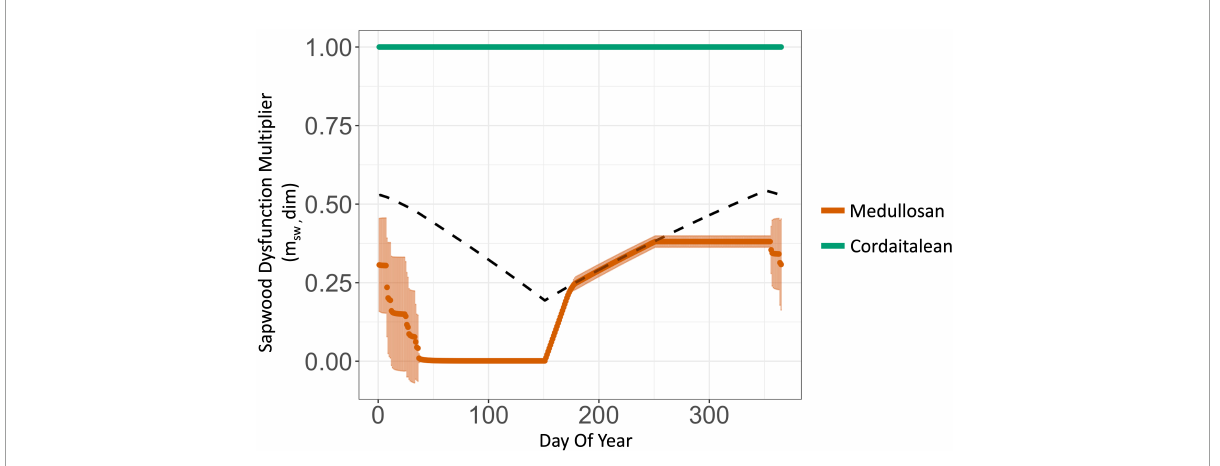
FIGURE6 Multiplier representing the proportional reduction in stomatal conductance as a result of by sapwood dysfunction due to embolism (m sw = 1 – PLC/100) and insufficient sapwood allocation (R ∗ max , dotted line). Stomatal conductance is unaffected in plant types resistant to sapwood dysfunction (cordaitalean, green), and reduced in vulnerable plant types (e.g., medullosan, orange). Medullosans were impacted by sapwood dysfunction because of their wide tracheids (165 µ m) and high pit area per tracheid (1.04 mm 2 ). The increase in m sw beginning at day 150 represents xylem regrowth at the start of the wet season. The dotted line represents the upper bound placed on stomatal conductance of the medullosan due to a sapwood:canopy allometric deficit (R ∗ max ) as a result of sapwood loss due to cavitation. For the cordaitalean R ∗ max was greater than one and therefore is not pictured. Only the final simulation year is presented.